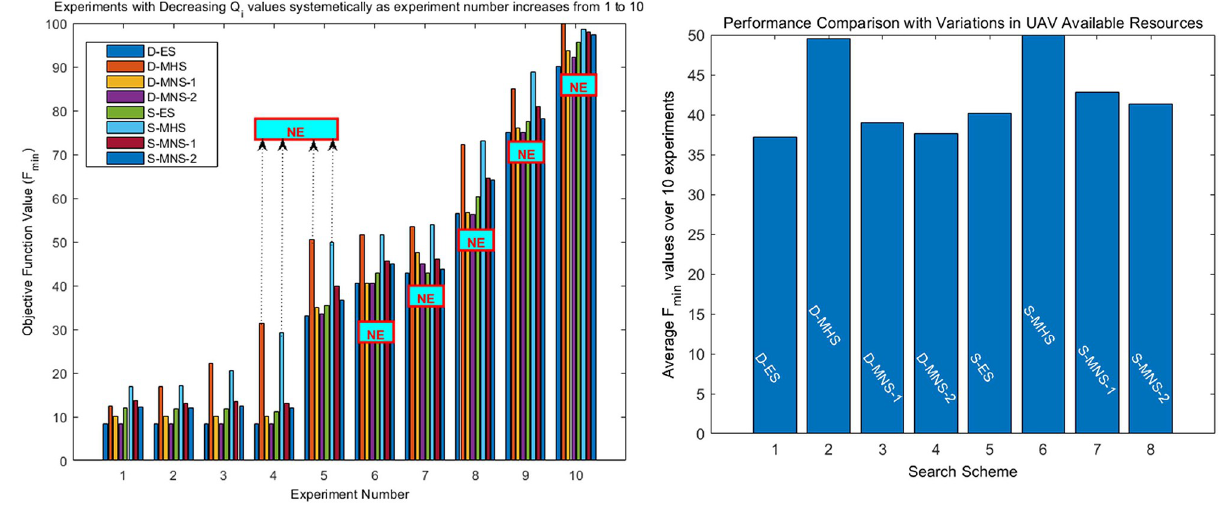
values are increasing uniformly as experiment number changes from 1 to 10 (b) arrival